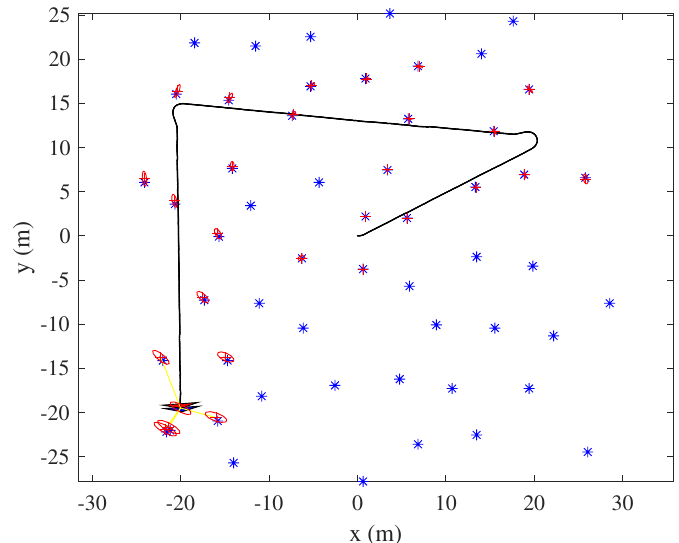
Figure 1. An example of extended Kalman filter (EKF)-simultaneous localization and mapping (SLAM) robot/landmark state when revisiting commences. The red ellipses reflect the covariances of registered landmarks; the red stars show the estimated positions of such landmarks; and the blue stars indicate the true positions of unregistered (unmapped)